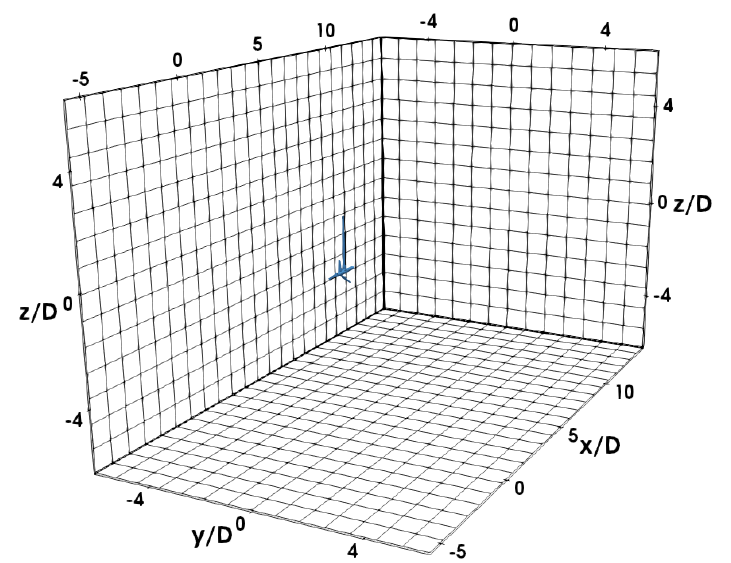
Figure 9. Numerical domain of LBM-LES simulations of the tidal turbine [6]. Mesh No. 1 is displayed on the boundaries of the domain, it is represented in cubes of 14 × 14 × 14 nodes. The domain is centred at the rotor centre and dimensions are scaled by the turbine diameter D